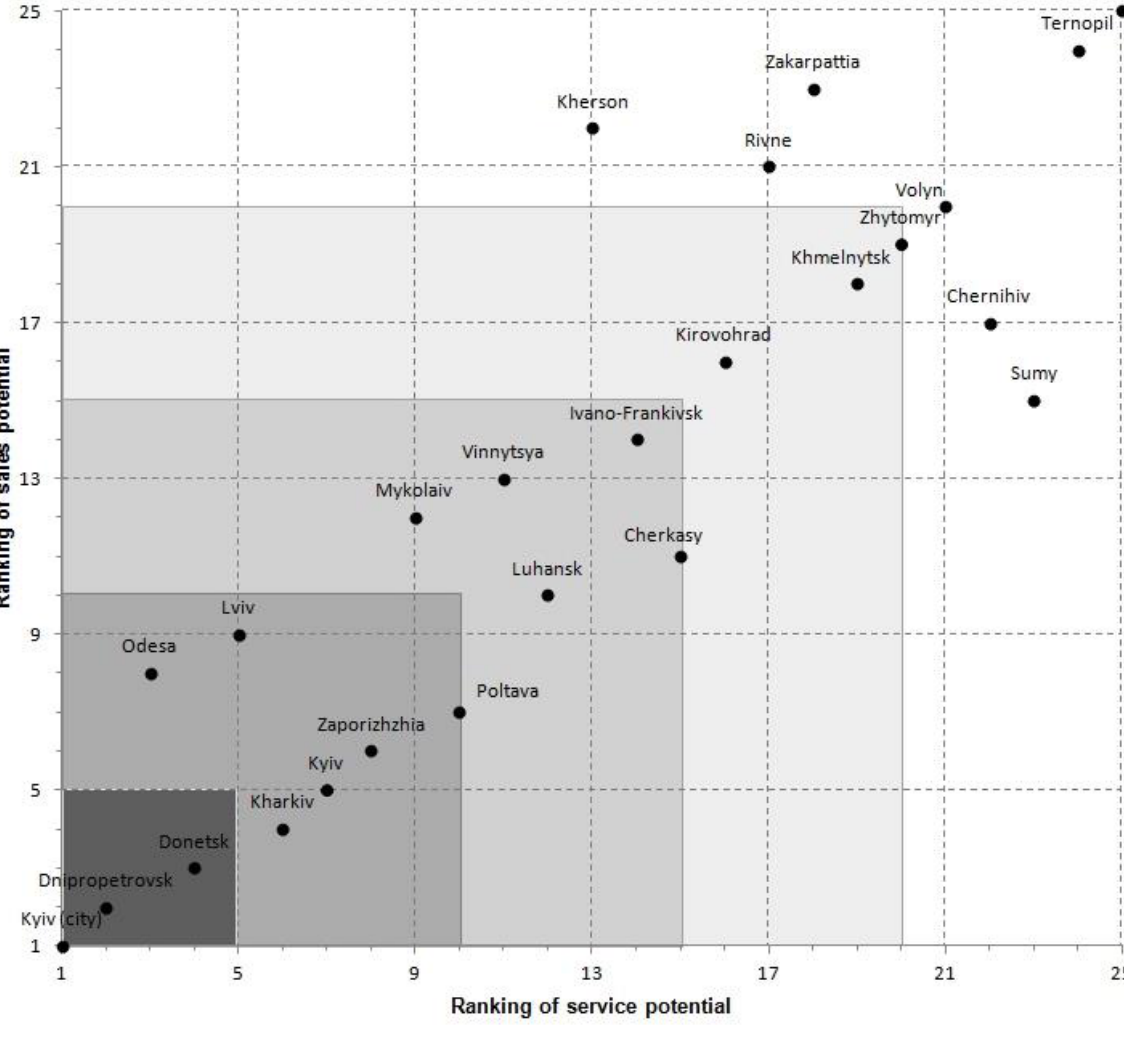
Fig. 13. The matrix of regions ’ sales and service